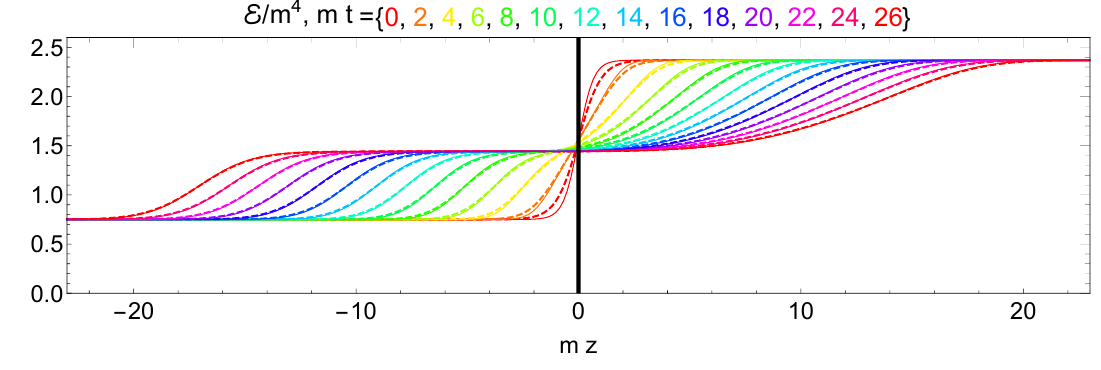
Figure 20: Evolution of the energy density for two different initial profiles: c = 3 (solid) and c = 1 (dashed). For mt (cid:166) 4 the evolution is insensitive to the initial